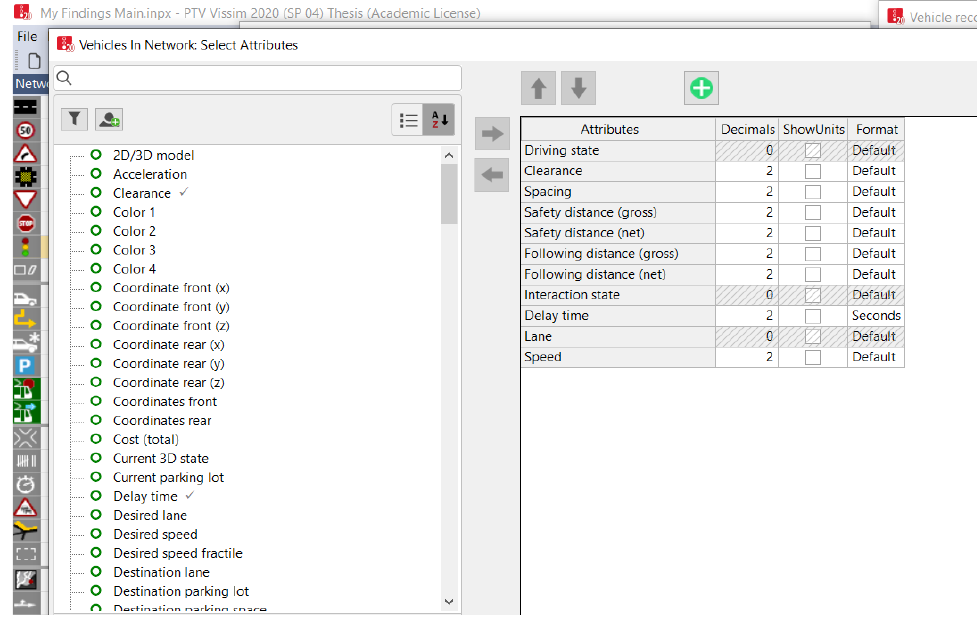
Figure 2. Some of the features influencing vehicle collision in the IoV environment.